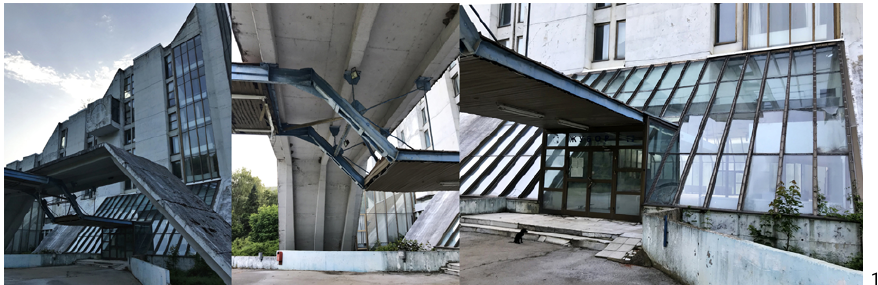
Fig. 10 Medical and Recreational Center Žubor in Kuršumlija Spa (1976-1982), Sculpture of Janez Boljka (left) and Front Facade (right) (Copyright Alek- sandra Jevtović, 2019) Fig. 11 Franc Avbelj et al., Medical and Recreational Center “Žubor” in Kuršumlija Spa (1976-1982), Details of Entrance Zone (Copyright Aleksandra Jevtović,